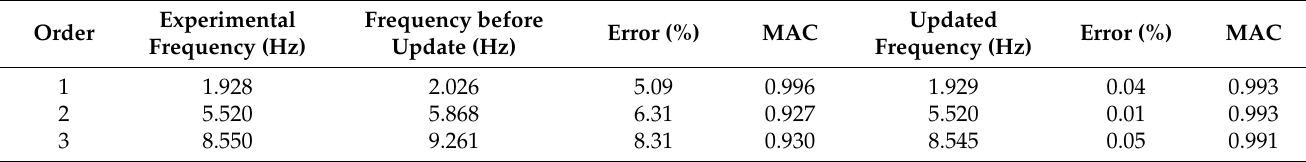
Table 7. The frequencies and MACs of experimental and numerical model.